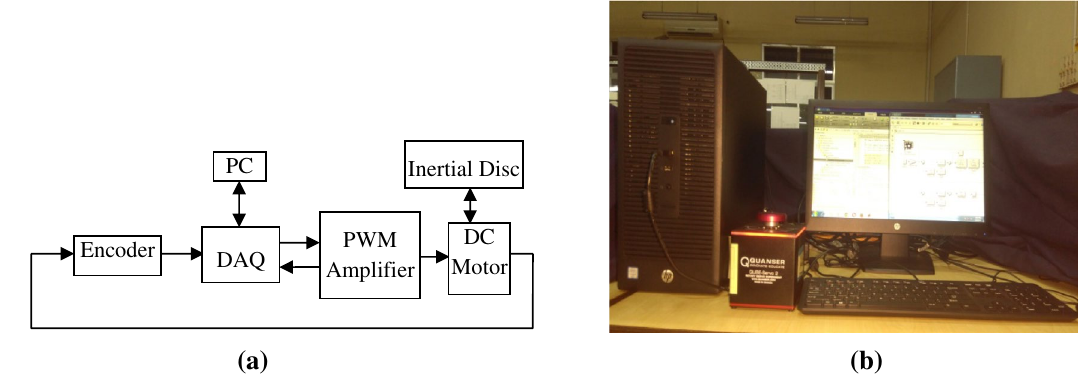
Fig. 24 a Block schematic for experimental setup of Quanser QUBE-Servo 2. b Snapshot of experimental setup of Quanser QUBE-Servo 2